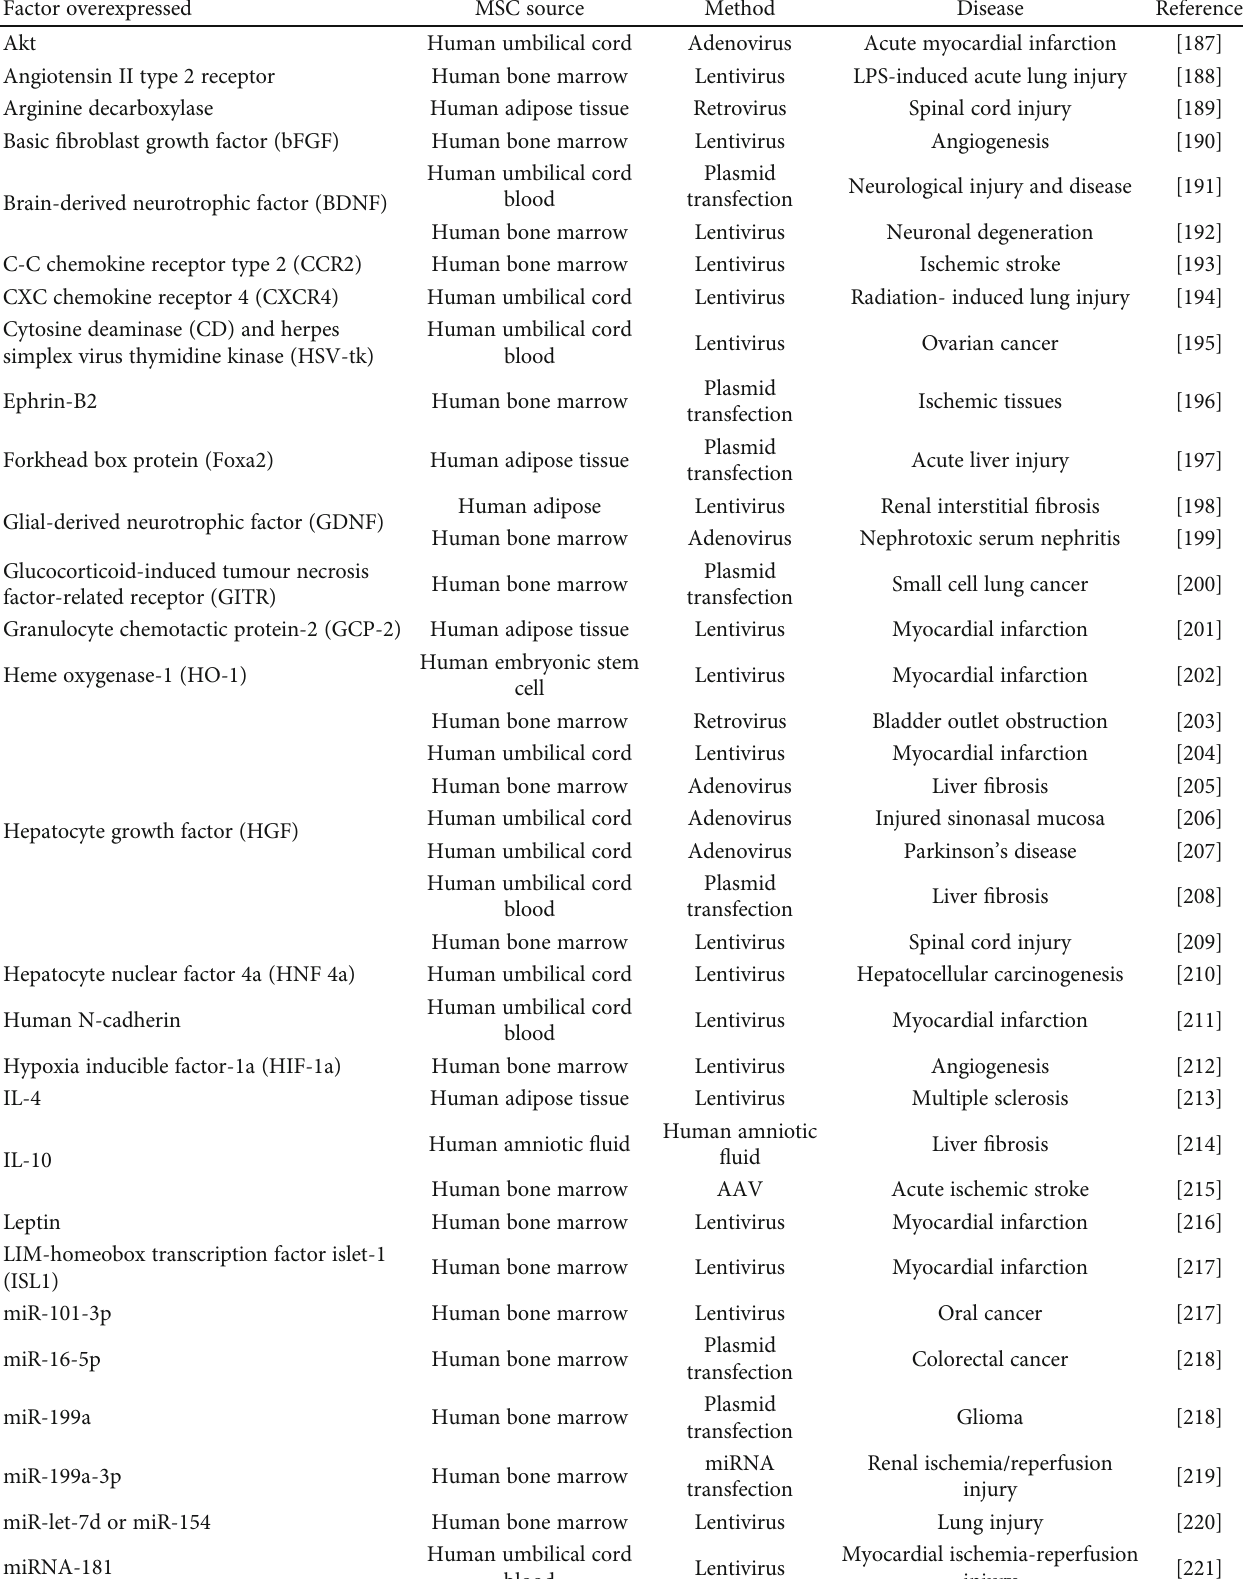
Table 5: Genetic modi fi cations in human MSCs and the disease models